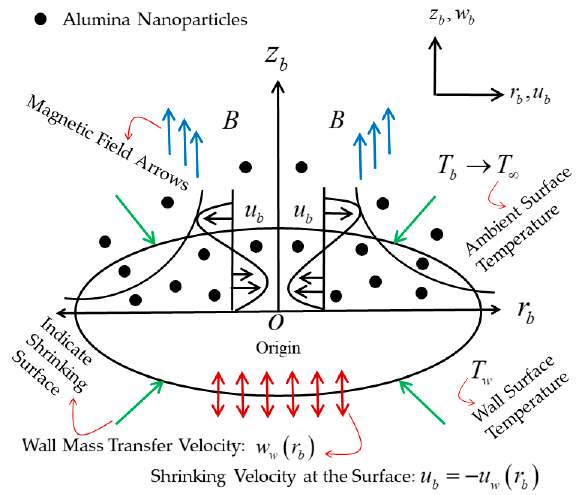
Figure 1. The physical model of the flow and coordinate system.